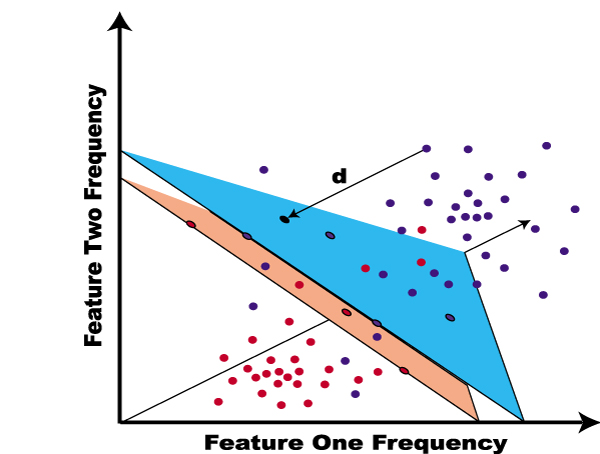
A sketch of the hyperplane separability heuristic for SVM binary classification. An SVM is trained to find an optimal hyperplane that separates positive and negative instances, while also constrained by structural risk minimization (SRM) criteria, which here manifests as the hyperplane having a thickness, or "margin," that is made as large as possible in seeking a separating hyperplane. A benefit of using SRM is much less complication due to overfitting (a common problem with Neural Network discrimination approaches). Given its geometric expression, it is not surprising that a key construct in the SVM formulation (via the choice of kernel) is the notion of "nearness" between instances (or nearness to the hyperplane, where it gives a measure of confidence in the classification, i.e., instances further from the decision hyperplane are called with greater confidence). Most notions of nearness explored in this context have stayed with the geometric paradigm and are known as "distance kernels," one example being the familiar Gaussian kernel which is based on the Euclidean distance: KGaussian(x,y) = exp(-DEucl.(x,y)2/2σ2), where DEucl.(x,y) = [∑k(xk-yk)2]1/2 is the usual Euclidean distance. Those kernels are used in the signal pattern recognition analysis in Figure 8 along with a new class of kernels, "divergence kernels," based on a notion of nearness appropriate when comparing probability distributions (or probability feature vectors). The main example of this is the Entropic Divergence Kernel: KEntropic = exp(-DEntropic.(x,y)2/2σ2), where DEntropic.(x,y) = D(x||y) + D(y||x) and D(..||..) is the Kullback-Leibler Divergence (or relative entropy) between x and y.